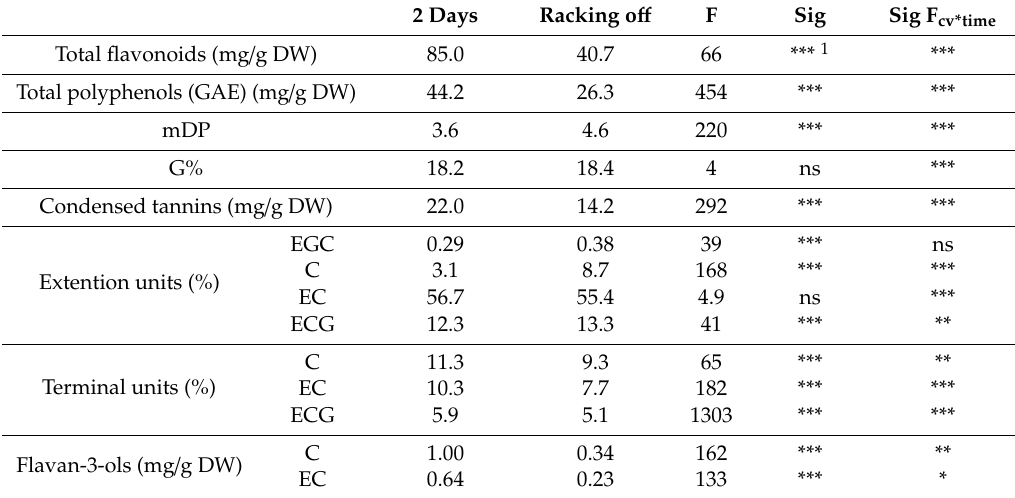
Table 3. Average polyphenolic composition of the grape seeds according to the sampling time (after 2 days of maceration and at racking o ff ). E ff ect of sampling time and interactions between sampling time andcultivar(2-factorsANOVA).mDP = meandegreeofpolymerization; G% = percentageofgalloylation; EGC = ( − )-epigallocatechin; C = ( + )-catechin; EC = ( − )-epicatechin; ECG = ( − )-epicatechin-3-O-gallate. 2 Days Racking o ff F Sig Sig F cv*time Total flavonoids (mg / g